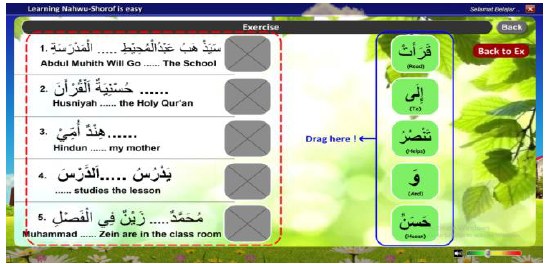
Figure 9. Arabic writing before